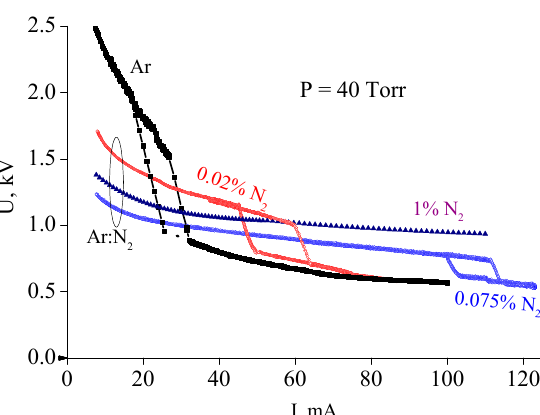
Figure 9. Volt–amp characteristics of a glow discharge in pure argon and in argon with nitrogen admixture. Percentages of admixture are indicated [16]. (© IOP Publishing. Reproduced with